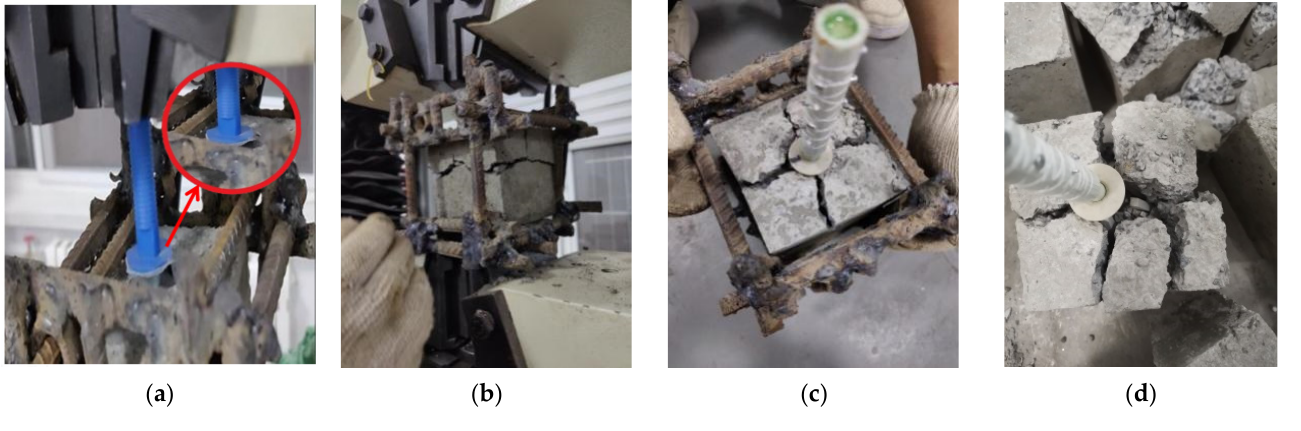
Figure 7. Damage state of pull-out-test specimens: ( a ) Rod connectors are pulled out; ( b ) Lateral concrete fracture of the claw connectors; ( c ) Cross-splitting of the upper part of the claw connectors; ( d ) Broken anchor-end jaws.